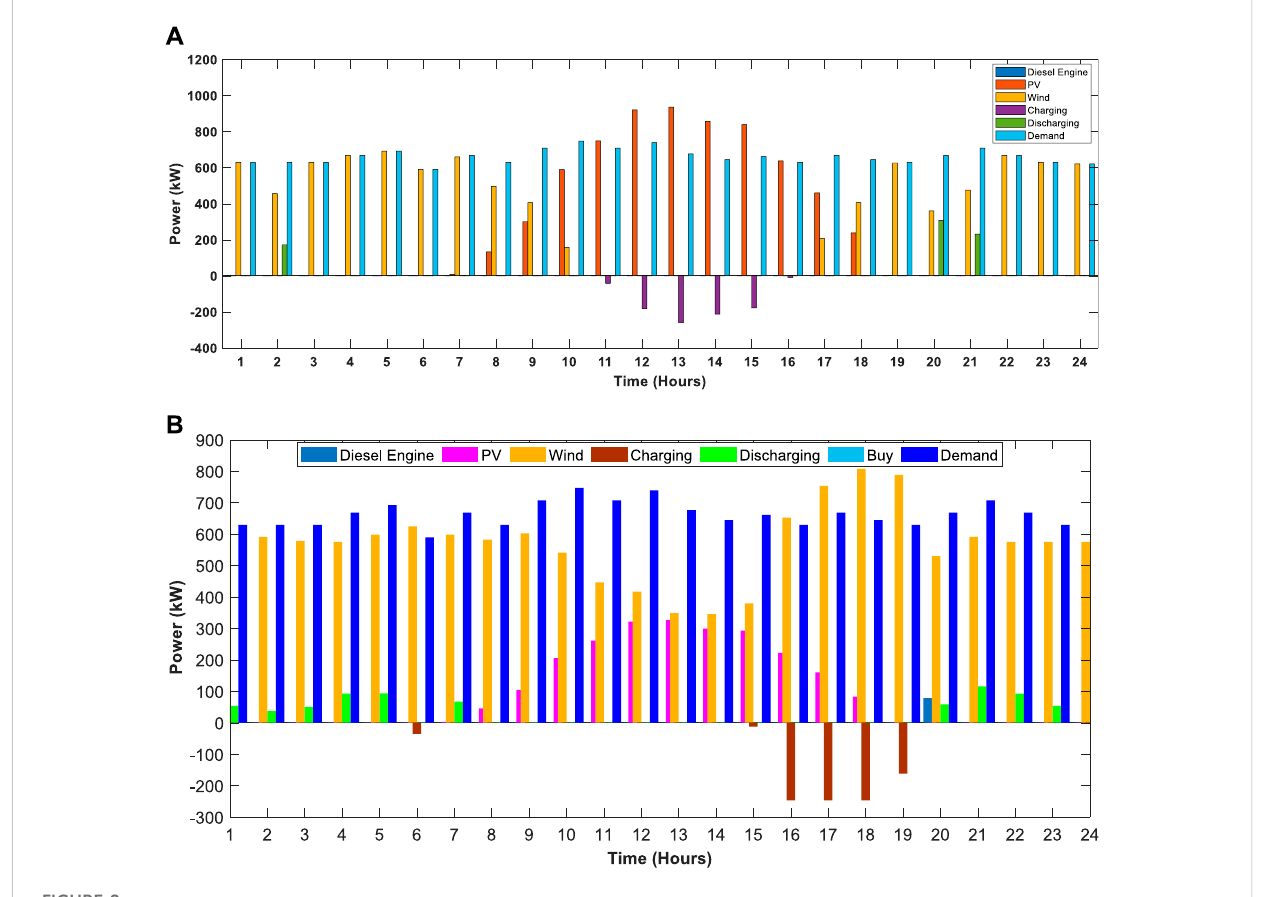
FIGURE 8 Power output curve meeting load demand on a typical day. (A) Stand-alone mode. (B) Grid-connected